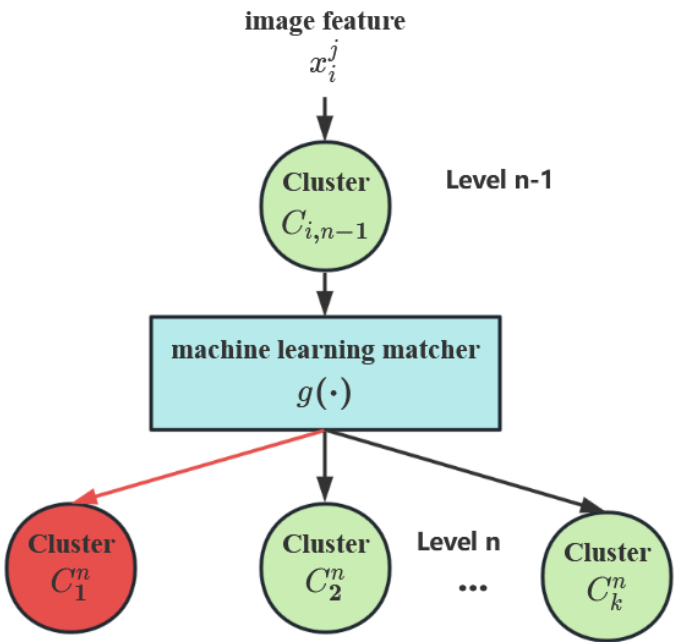
Figure 5. Matching an image feature to its belonging